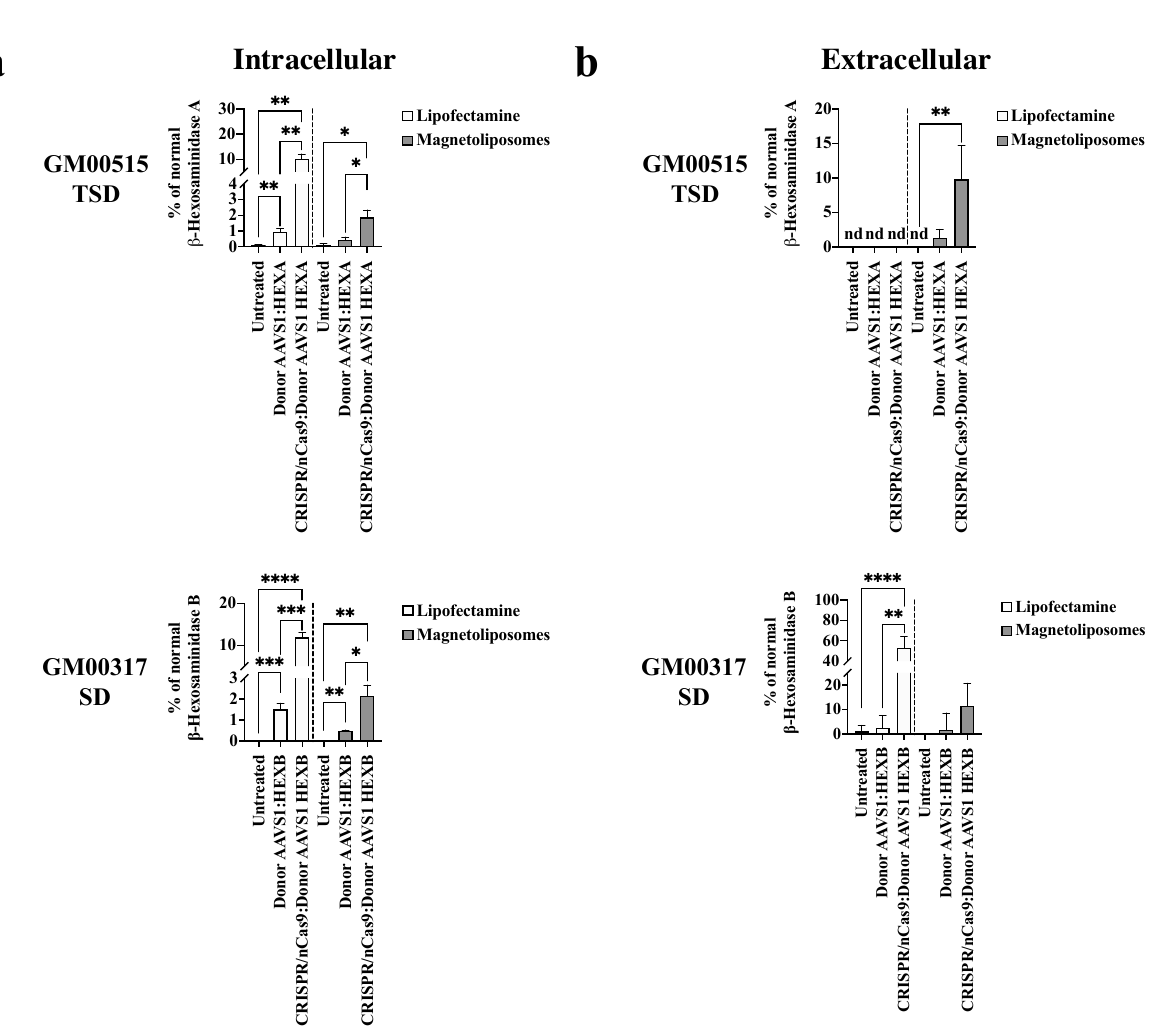
Figure 5. β -hexosaminidase activity on long-term edited GM2 fibroblasts. The intracellular ( a ) and extracellular ( b ) enzyme activity to wild-type levels for GM00515-TSD and GM00317-SD fibroblasts is shown ( n = 4). * p ≤ 0.05, ** p ≤ 0.01,*** p ≤ 0.001, **** p ≤ 0.0001. Two-tailed Student’s t -test. Consistently, the intracellular Hex A (10.1 ± 2% of WT levels, p = 0.001) and Hex B (11.9 ± 1.2% of WT levels, p ≤ 0.0001) activity was higher with the LPs-assisted delivery compared to the MLPs, for which Hex A and Hex B activity levels were 1.9 ± 0.4% ( p = 0.0229) and 2.2 ± 0.5% ( p = 0.0051) of WT levels, respectively (Figure 5a).